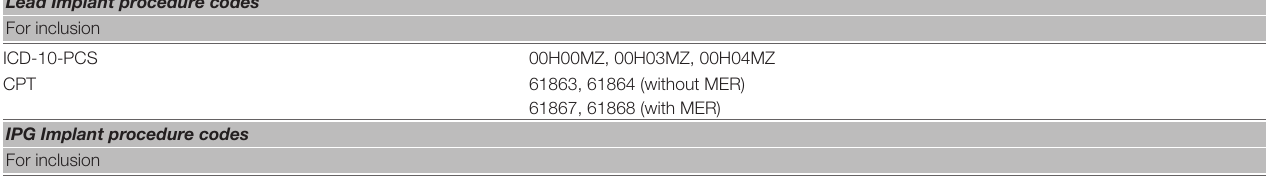
TABLE 1 | List of procedure codes defining reoperations and diagnosis codes used for classifying reason for